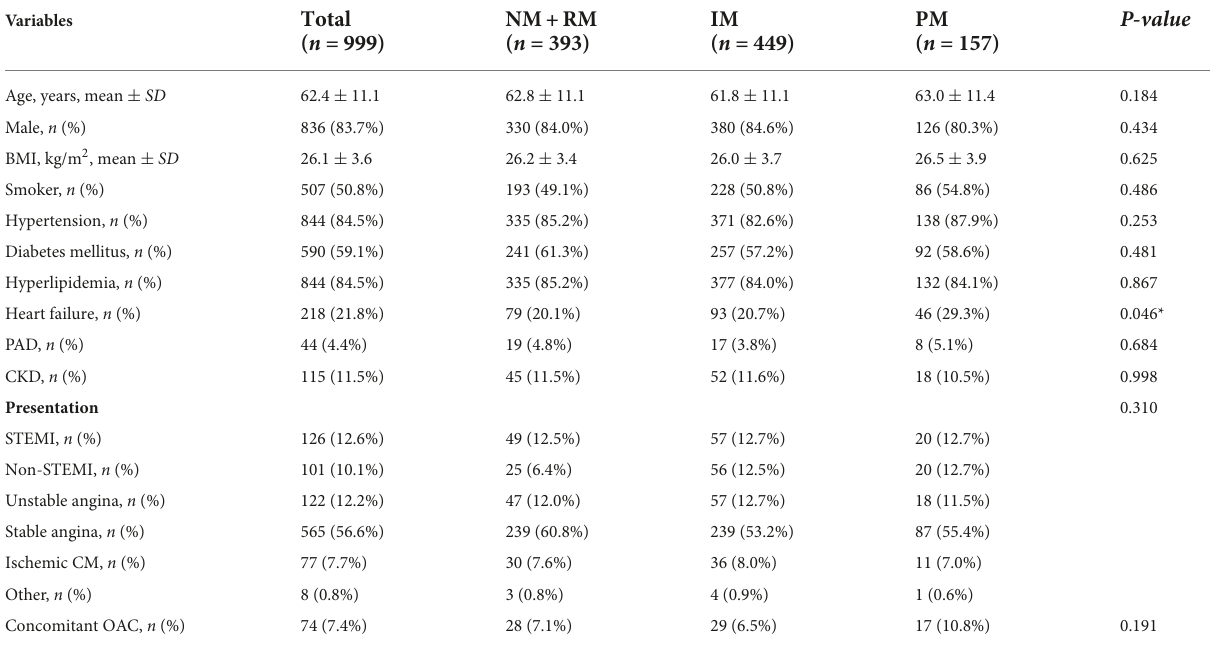
TABLE 2 Baseline demographics of the